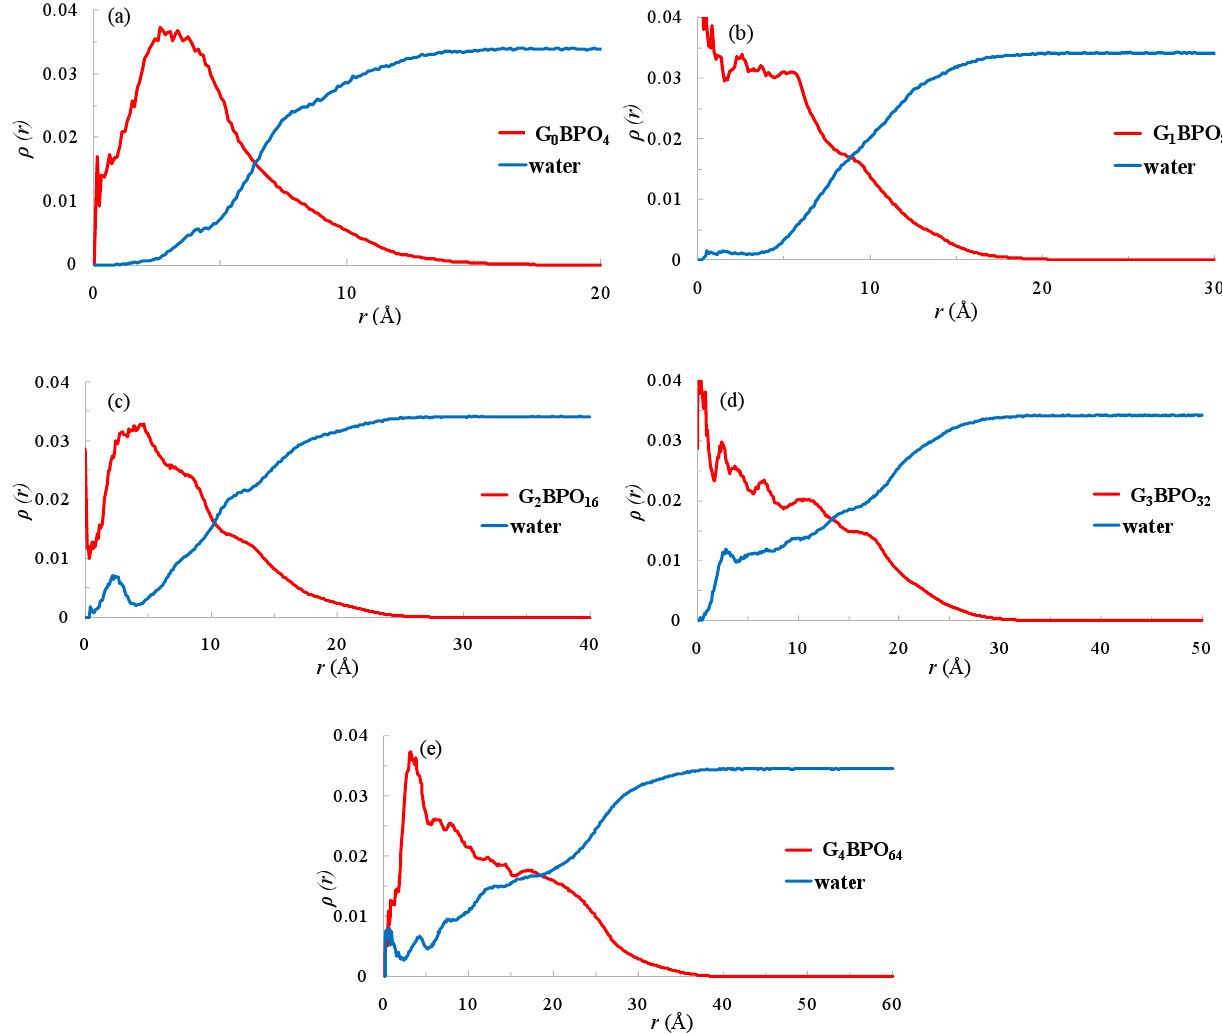
Figure 10. Density distributions of dendrimer and water with respect to the center-of-mass of the dendrimer for all the examined